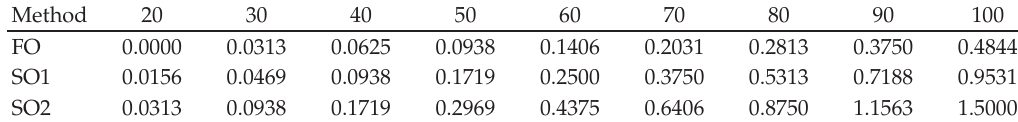
Table 4: CPU times.